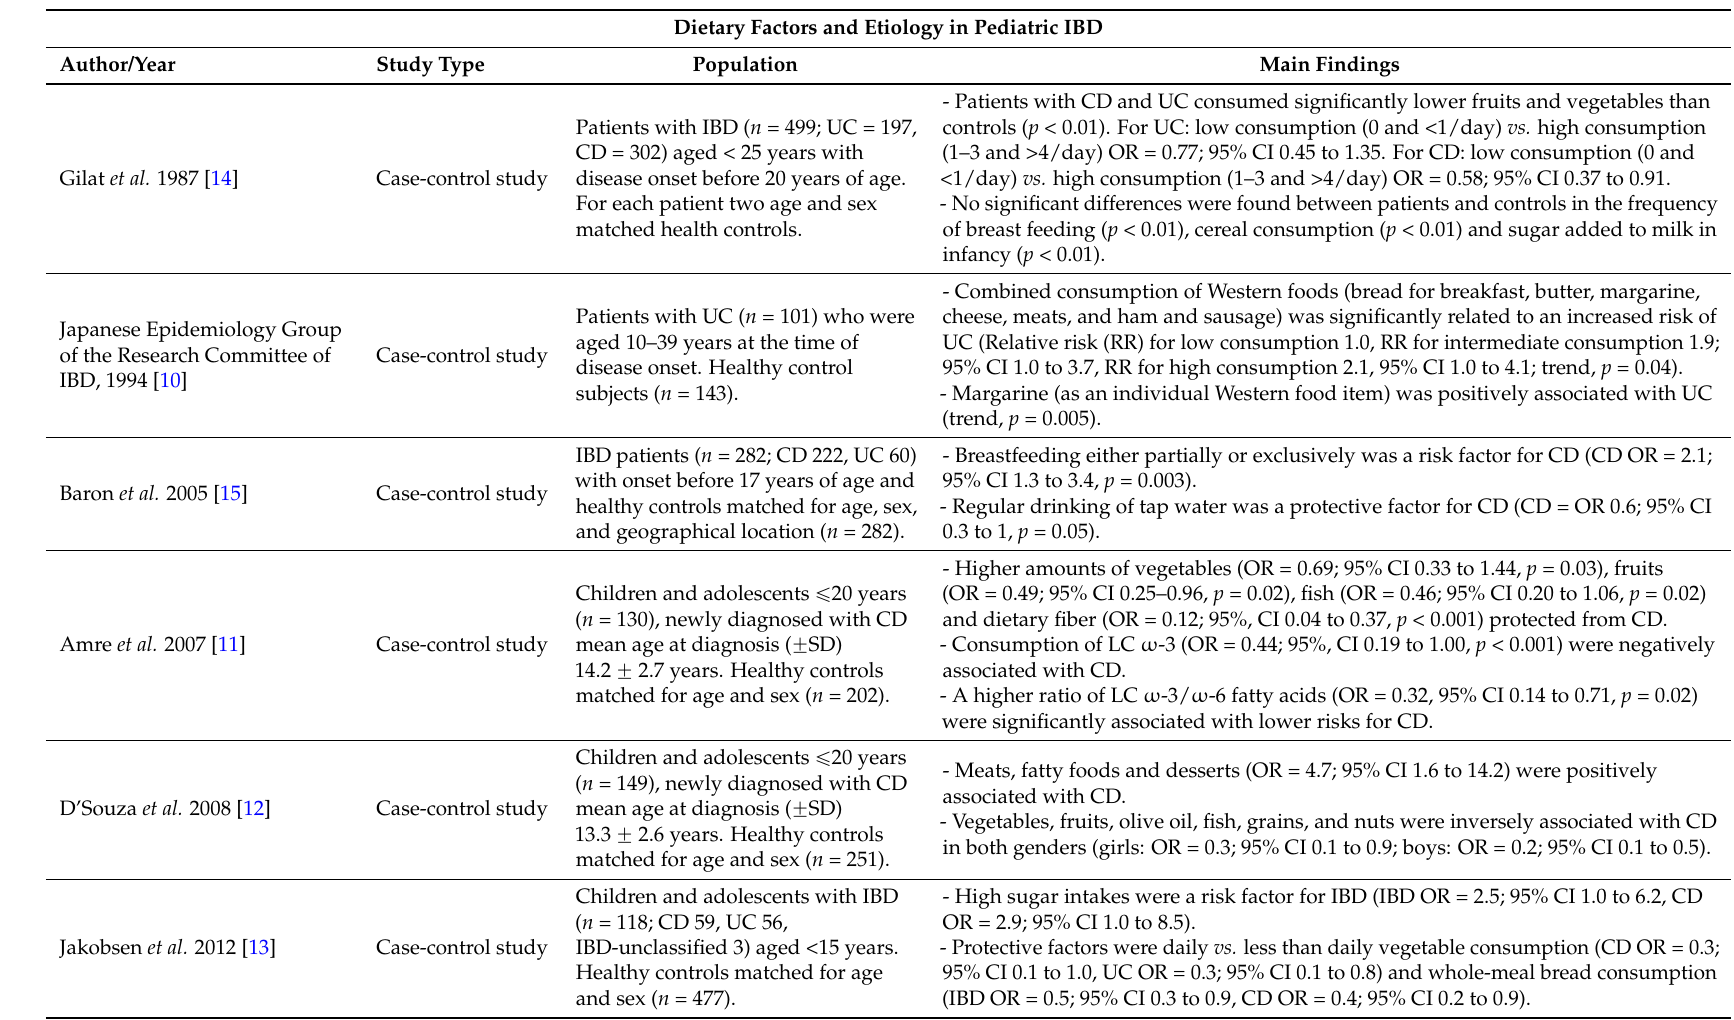
Table 1. Dietary factors and etiology in pediatric IBD. IBD = inflammatory bowel disease, UC = ulcerative colitis, CD = Crohn’s disease, LC = long